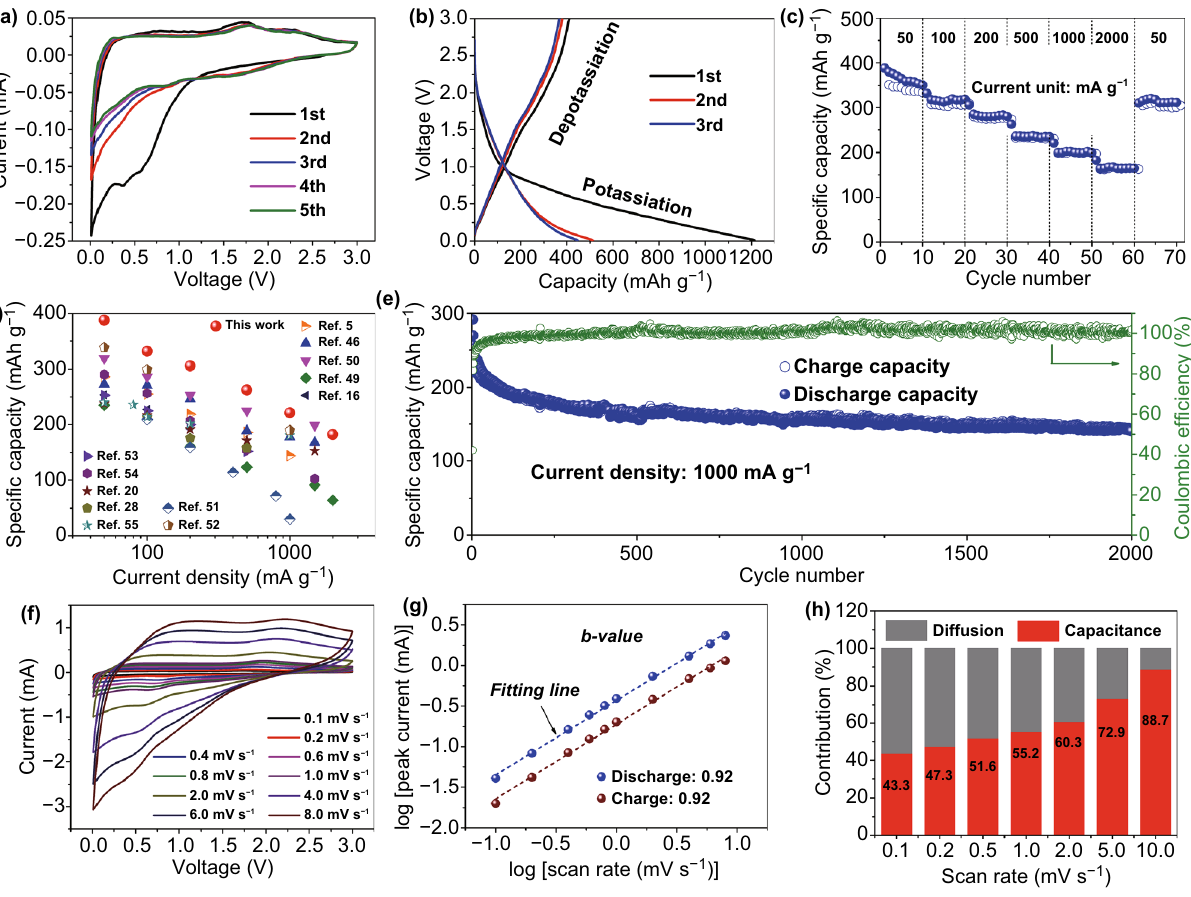
Fig. 3 Electrochemical properties of the S-MCCF in PIBs: a cyclic voltammetry curves at a scan rate of 0.1 mV s −1 , b galvanostatic charge/dis- charge profiles of the first three cycles at 50 mA g −1 , c rate performance tested at various current densities (excluding the data of the first cycle at a small current density of 50 mA g −1 ), d rate capability of the S-MCCF compared with that of the other carbonous electrodes, and e long-term cycling property at 1000 mA g −1 (excluding the data of the first cycle). Electrochemical dynamics analysis of the K + storage mechanism of the S-MCCF: f cyclic voltammetry curves at various scan rates, g determination of the b -value, and h contribution ratios of the capacitance and dif- fusion capacities at scan rates ranging from 0.1 to 10 mV s